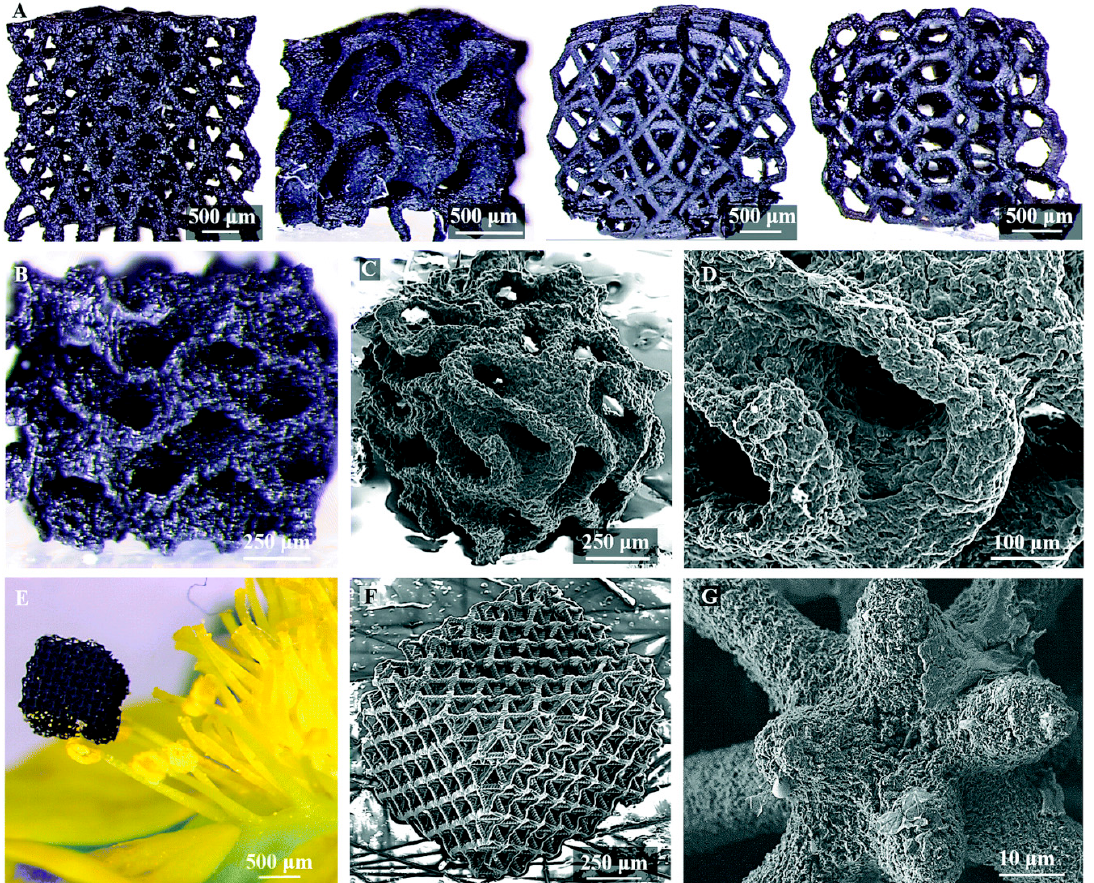
Figure 8. ( a ) Four “Green” MAG parts of differing unit-cell structures before pyrolysis from left to right: octet-truss, gyroid, cubo-octahedron, and Kelvin foam; ( b ) optical image of pyrolyzed gyroid; ( c ) SEM image of pyrolyzed gyroid with intricate overhang structures ( d ) zoomed image of pyrolyzed gyroid in ( c ); ( e ) optical image of pyrolyzed MAG octet-truss, of a different design than shown in ( a ) supported by a single strawberry blossom filament; ( f ) SEM image of pyrolyzed octet-truss MAG in ( e ); ( g ) zoomed image of octet-truss in ( e ) showing the very high 10 micron resolution achievable in our process. Reproduced from [173], with permission from the Royal Society of Chemistry, 2018.